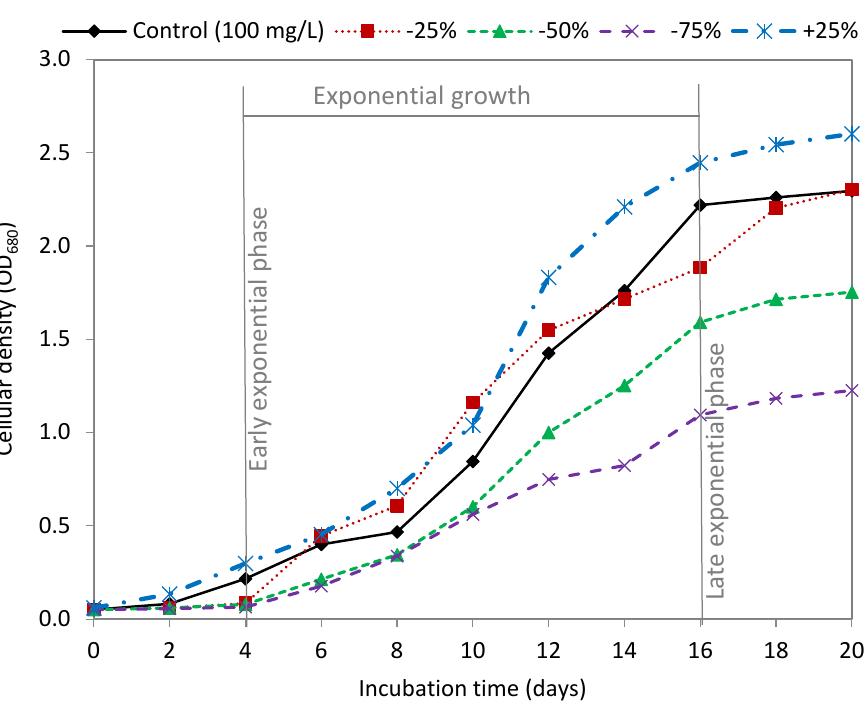
Figure 1. Effect of different concentrations of sodium nitrate on growth of Chlorella sp. cultivated for 20 days in synthetic wastewater. Table 1. Effect of different concentrations of sodium nitrate on biomass and lipids of Chlorella sp. cultivated in synthetic wastewater and harvested at the late exponential phase.